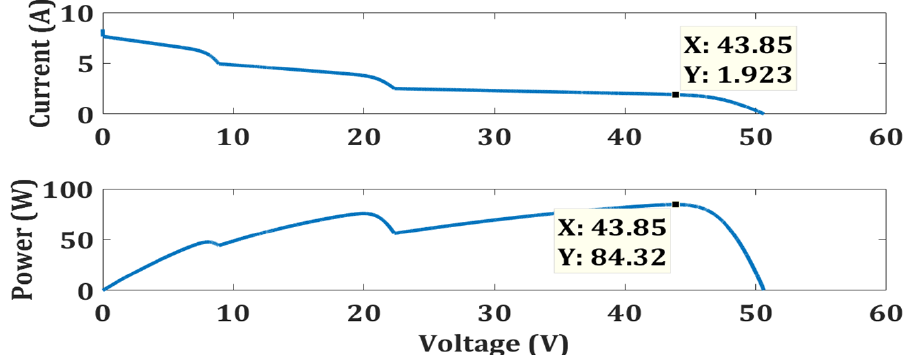
Figure 15. Characteristic curve of 4S2P PV system for test case 3.